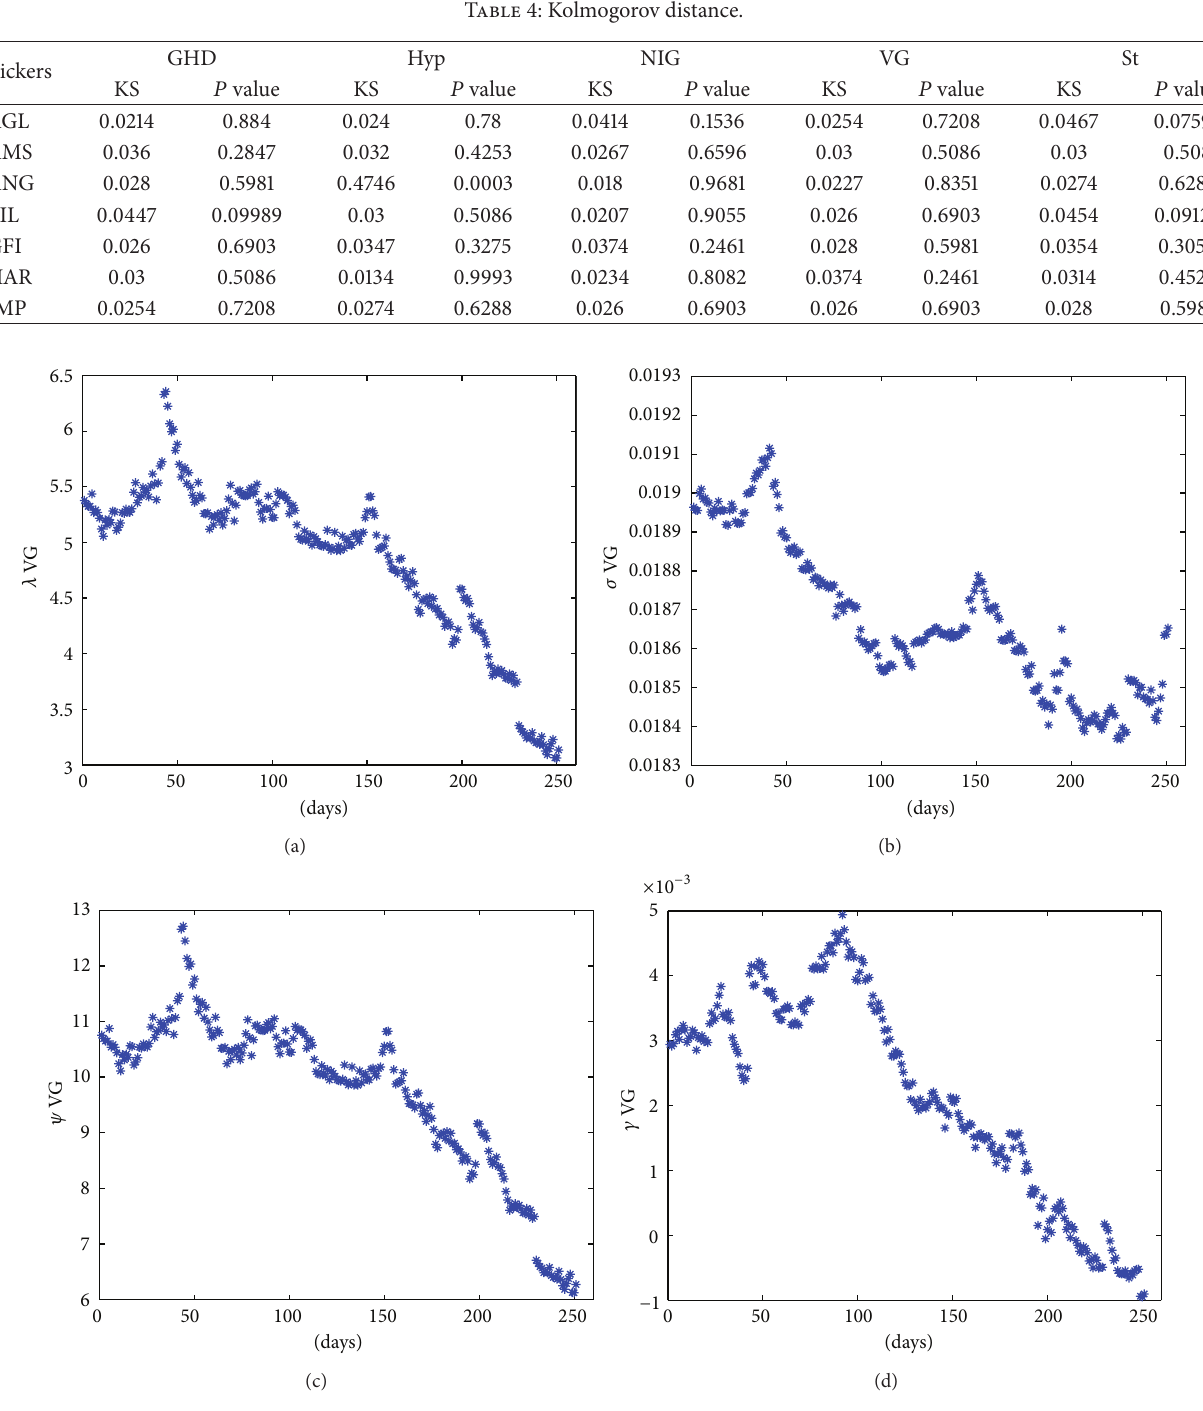
Figure 3: Daily variation of 𝜆 , 𝜎 , 𝜓 , and 𝛾 for AGL with